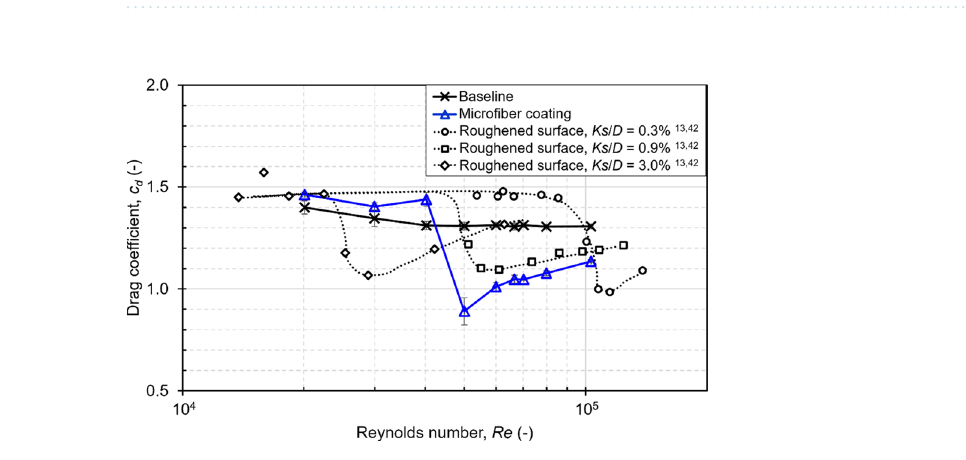
Figure 4. Normalized velocity profile in the wake of different cylinder configurations. The Re based on the cylinder diameter was 6.6 × 10 4 .